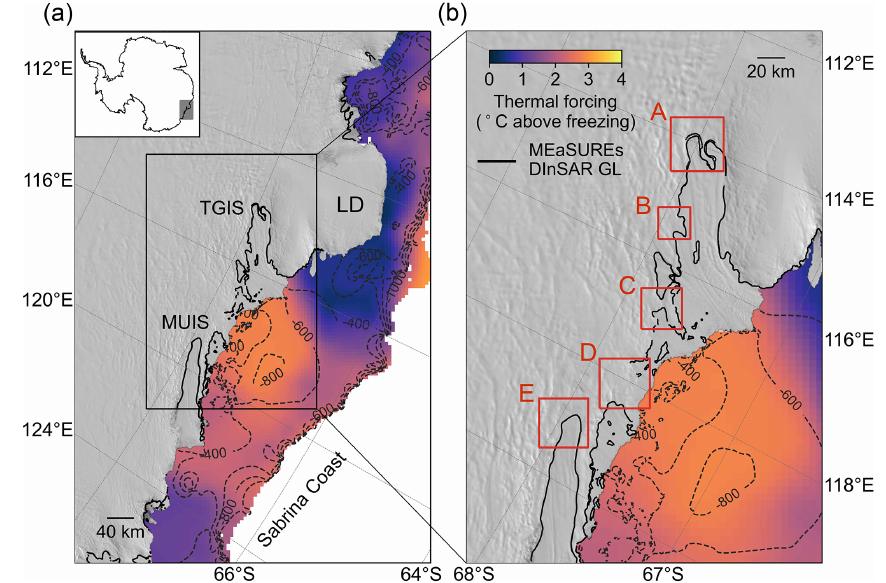
Figure 1. (a) Totten Glacier Ice Shelf (TGIS), Moscow University Ice Shelf (MUIS), and Law Dome (LD) in Wilkes Land overlaid with the MODIS mosaic of Antarctica (Scambos et al., 2007), and the maximum ocean thermal forcing (temperature above the in situ freezing point) between water depth of 200 and 800m (Adusumilli et al., 2020) on Sabrina Coast. The MEaSUREs differential synthetic aperture radar interferometry (DInSAR) grounding lines (GLs) are shown as black lines (Rignot et al., 2011, 2016), the BedMachine bed elevation (Morlighem et al., 2020) contours at − 400, − 600, − 800, and − 1000m of the seafloor are shown as dashed dark grey lines. (b) Zoomed-in map of the TGIS and MUIS outlined as the black box in (a) ; A, B, C, D, and E red boxes denote five studied regions including TGIS, Totten Glacier East Branch (TGEB), Totten Glacier Eastern Ice Shelf (TGEIS), Moscow University Western Ice Shelf (MUWIS), and MUIS,